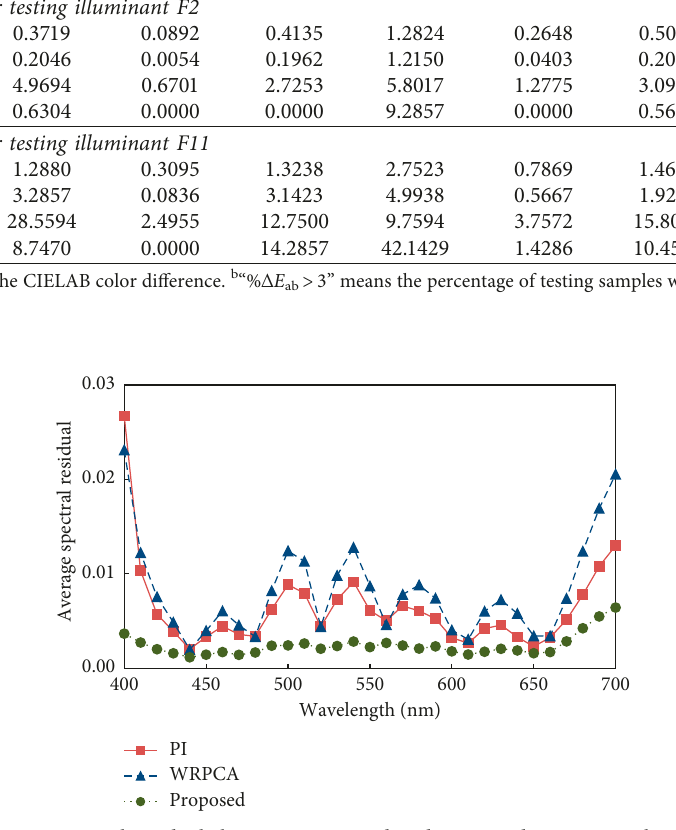
Figure 2: Average spectral residuals between recovered and measured spectra on the Munsell chips.